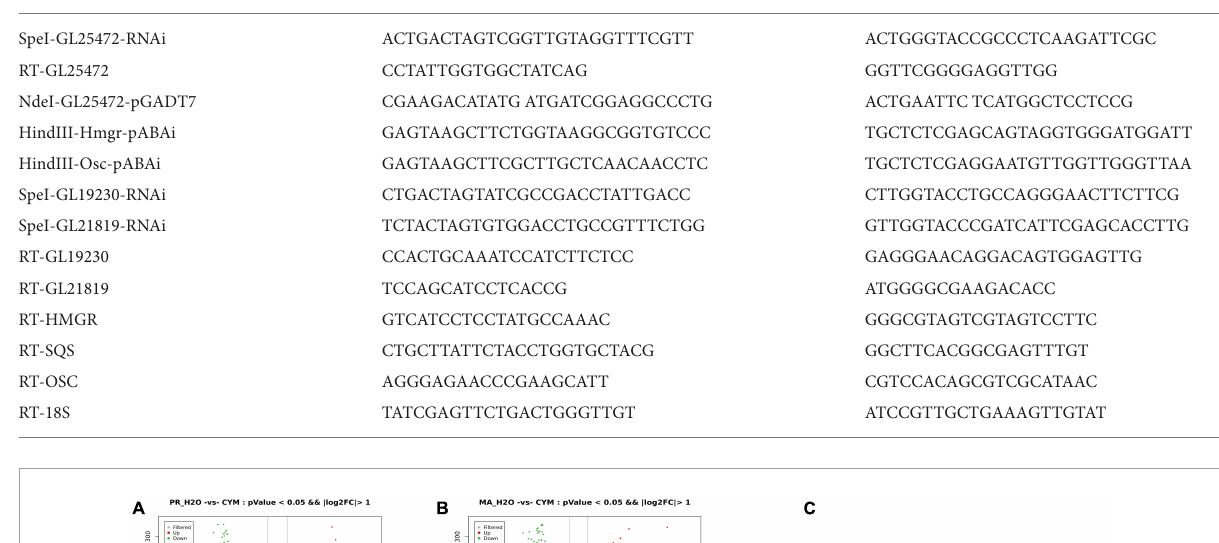
TABLE 1 The primers in this study.